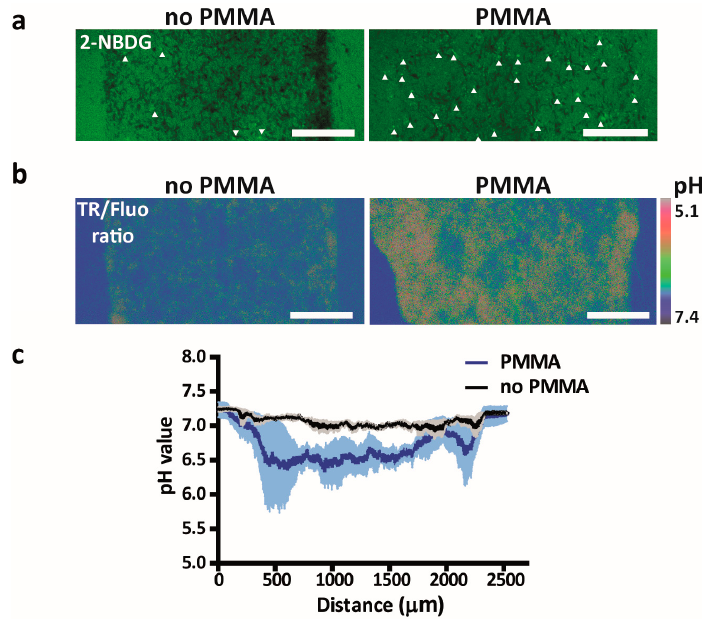
Figure 4. Investigation of the metabolic switch of U-251 MG cells cultured in the tumor-on-a-chip platform. (a) 2-NBDG uptake by U-251 MG cells cultured in devices with or without a PMMA sheet. Arrows indicate cells with enhanced 2-NBDG uptake. (b) Representative image of the fluorescence ratio of TAMRA and fluorescein (TR/Fluo) of a dual-labeled dextran as a pH sensor in microfluidic devices loaded with U-251 MG cells with or without a PMMA sheet. Scale bars represent 500 μ m. (c) Quantified pH values in the device based on the ratio of the intensities of the two dyes (TR/Fluo) of the dual-labeled dextran for devices as illustrated in panel b. Lines depict averages at distinct positions in the devices and the shaded areas indicate the s.e.m.